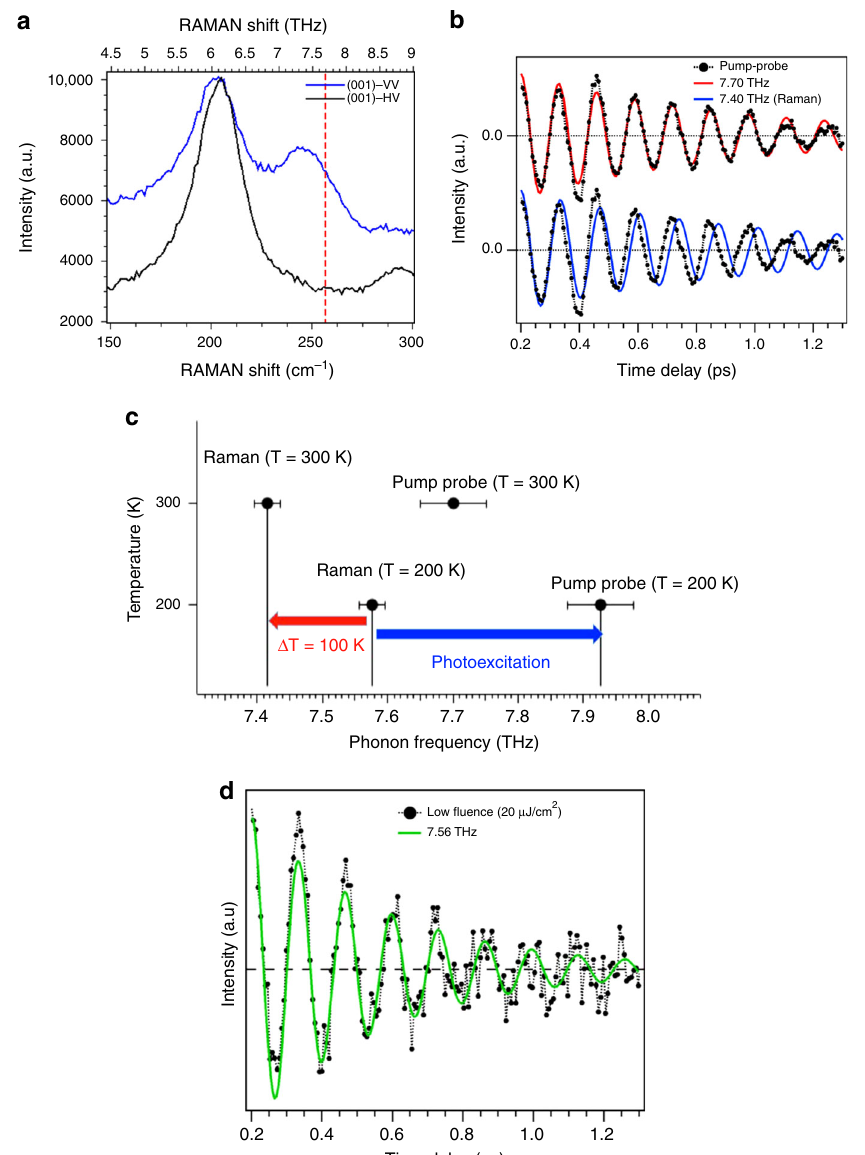
Fig. 1 a Raman spectroscopy on a V 2 O 3 single crystal with the c axis perpendicular to the surface at 295 K. The A 1g phonon mode is visible at 7.4 THz in the parallel polarization con fi guration (VV). The vertical dashed line indicates the phonon frequency as derived by fi tting the time resolved re fl ectivity curve in b . b pump-probe re fl ectivity at a 8 mJ/cm 2 fl uence on the same specimen in the same experimental conditions, at 295 K. At the top, the background subtracted experimental data are compared with the best sinusoidal fi t with a 7.7 THz frequency (in red). At the bottom, the same data are compared to the same sinusoidal function but at 7.4 THz (in blue), corresponding to the Raman frequency. c comparison between thermal and pump-probe shifts. At 200 K, the A 1g mode frequency is 7.58 THz; by increasing the temperature to 300 K ( Δ T = 100 K) the Raman frequency presents a red shift of 0.16 THz; conversely, under ultrafast excitation, it undergoes a blue-shift of 0.35 THz. d low fl uence measurements performed at 20 μ J/cm 2 at room temperature; these data were obtained at a repetition rate of 5 MHz. The best fi t (green curve) gives a frequency of 7.56